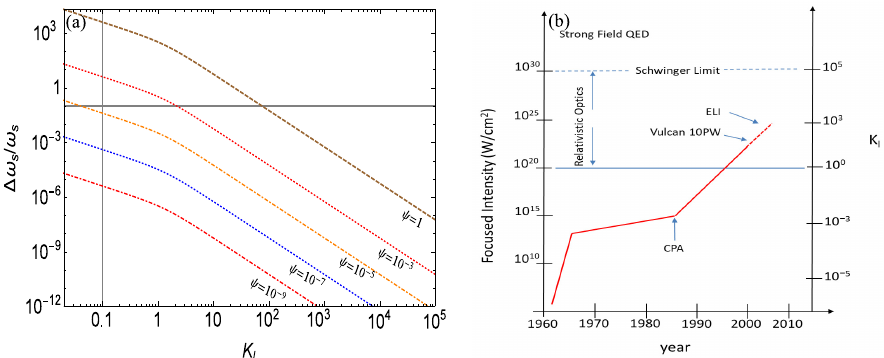
Figure 15. ( a ) Log-Log plot of ∆ ω s / ω s vs. K l for different values of ψ and γ = 100. The line K l = 0.1 is the ideal separation of the linear regime ( K l < 1) from the non-linear regime ( K l > 1). The line ∆ ω s / ω s = 0.1 separates the Compton regime ( ∆ ω s / ω s > 0.1) from the Thomson regime ( ∆ ω s / ω s < 0.1). ( b ) Correspondence with the chart (adapted form Ref. [58]) regarding the evolution of high power lasers including also the historical evolution of light power laser technology. The knee marked with CPA is the breakthrough due to the introduction Chirped Pulse Amplification